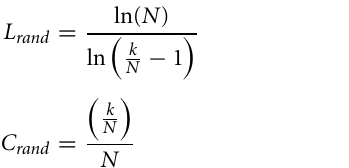
and the 3 interrelated dependent variables (small-world